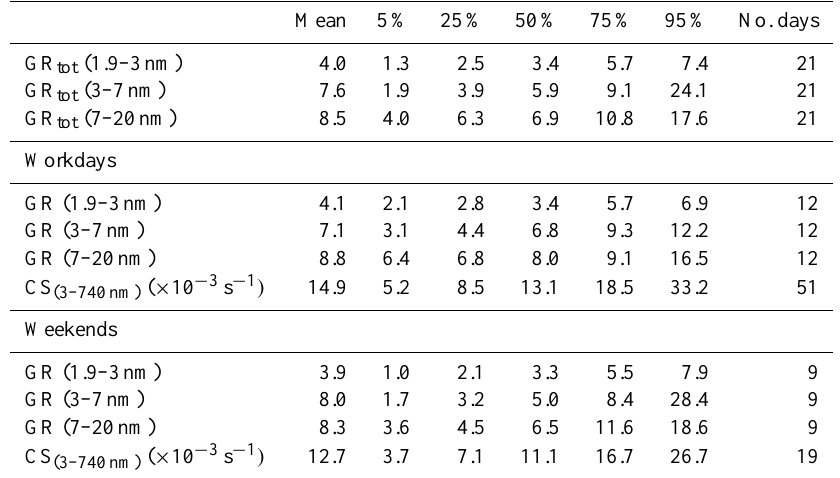
Table 2. Growth rates of ions (mean of positive and negative) calculated from 21 NPF event days (9 workdays and 12 weekends). The total growth rates (GR tot ) include both workdays and weekends. The unit for GR isnmh − 1 . The CS calculations were based on TDMPS data from Jul 2009 and January/February 2010 (hourly